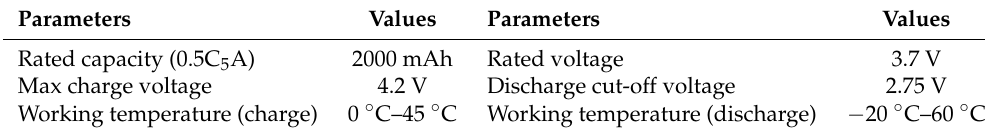
Table 1. LIB 18650 cell